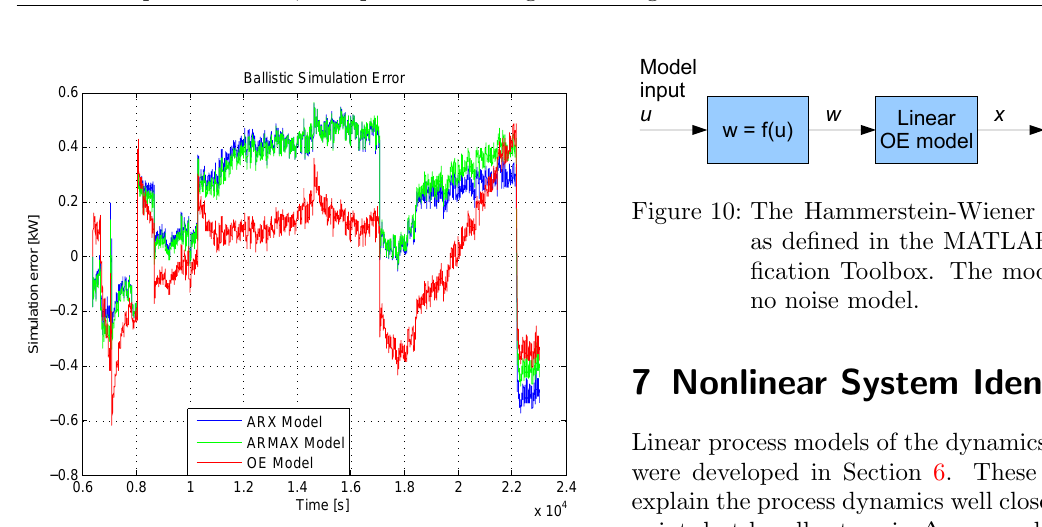
Figure 9: Ballistic simulations error using the ARX, ARMAX, and OE models.